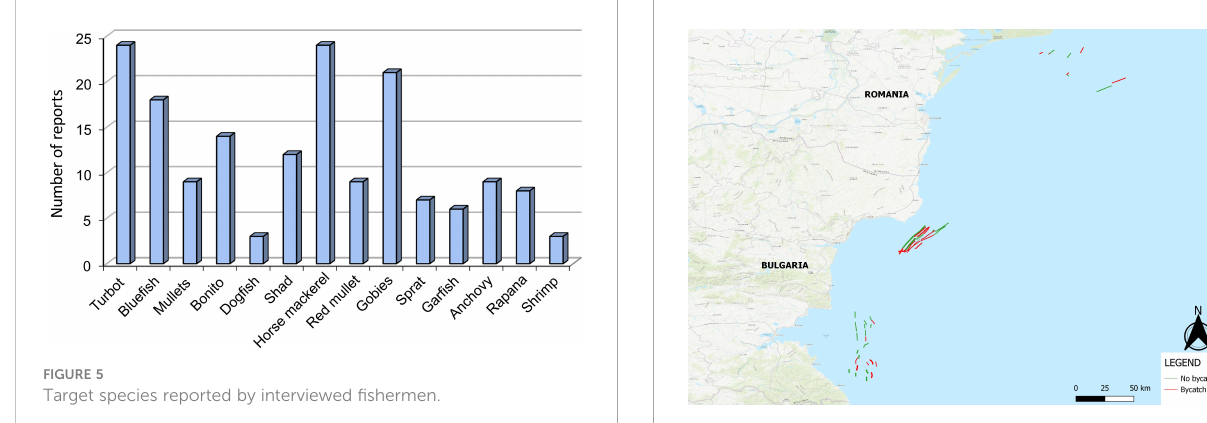
FIGURE 7 Geographic distribution of onboard bycatch observations in the Western Black Sea.